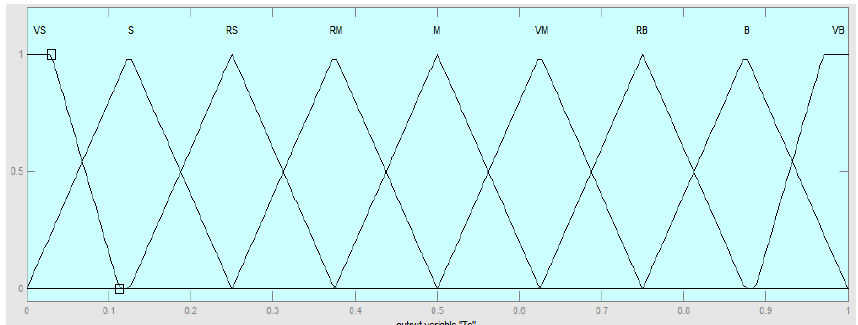
Figure 3. Battery state-of-charge (SOC) membership function.